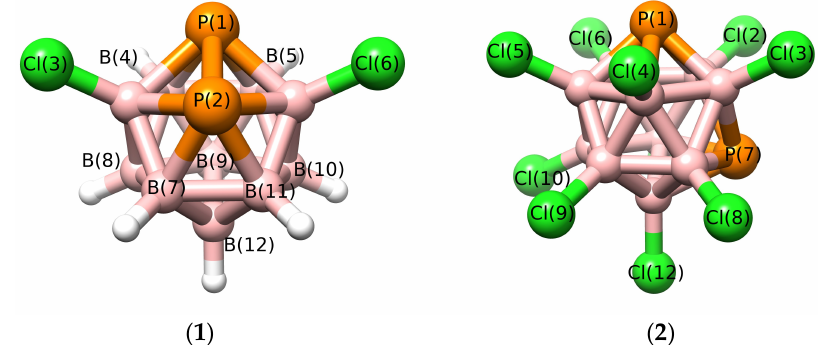
Figure 1. The molecular diagrams and numbering of 3,6-Cl 2 - closo -1,2-P 2 B 10 H 8 ( 1 ) and closo -1,7-P 2 B 10 Cl 10 ( 2 ).